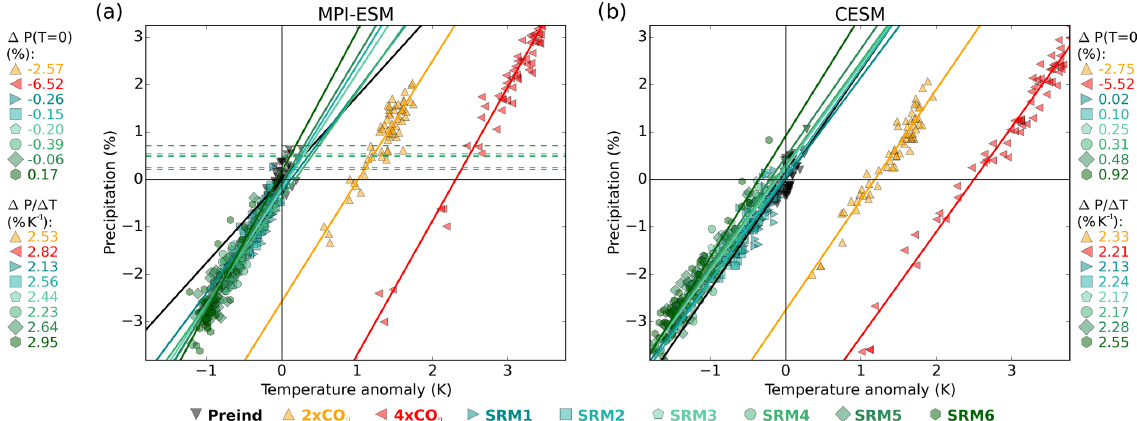
Figure 4. Gregory plots of global precipitation changes under increased CO 2 (orange and red) and SRM scenarios with differing sulfur injection amounts (blue to green) for (a) MPI-ESM and (b) CESM. Each marker indicates a single-year global mean value for one of three ensemble members, and solid lines are linear fits. Origin represents zero temperature and precipitation anomaly compared to the Preind simulation. A fast precipitation response is obtained from the intersection of the linear fit and the y axes ( T = 0) (shown at the top of the legends next to the panels), and the slope of the linear fit (shown at the bottom of the legends) corresponds to the slow response due to the temperature change. Dashed lines show (fast) precipitation responses for the corresponding scenarios in ECHAM-HAMMOZ (simulations with fixed SST).